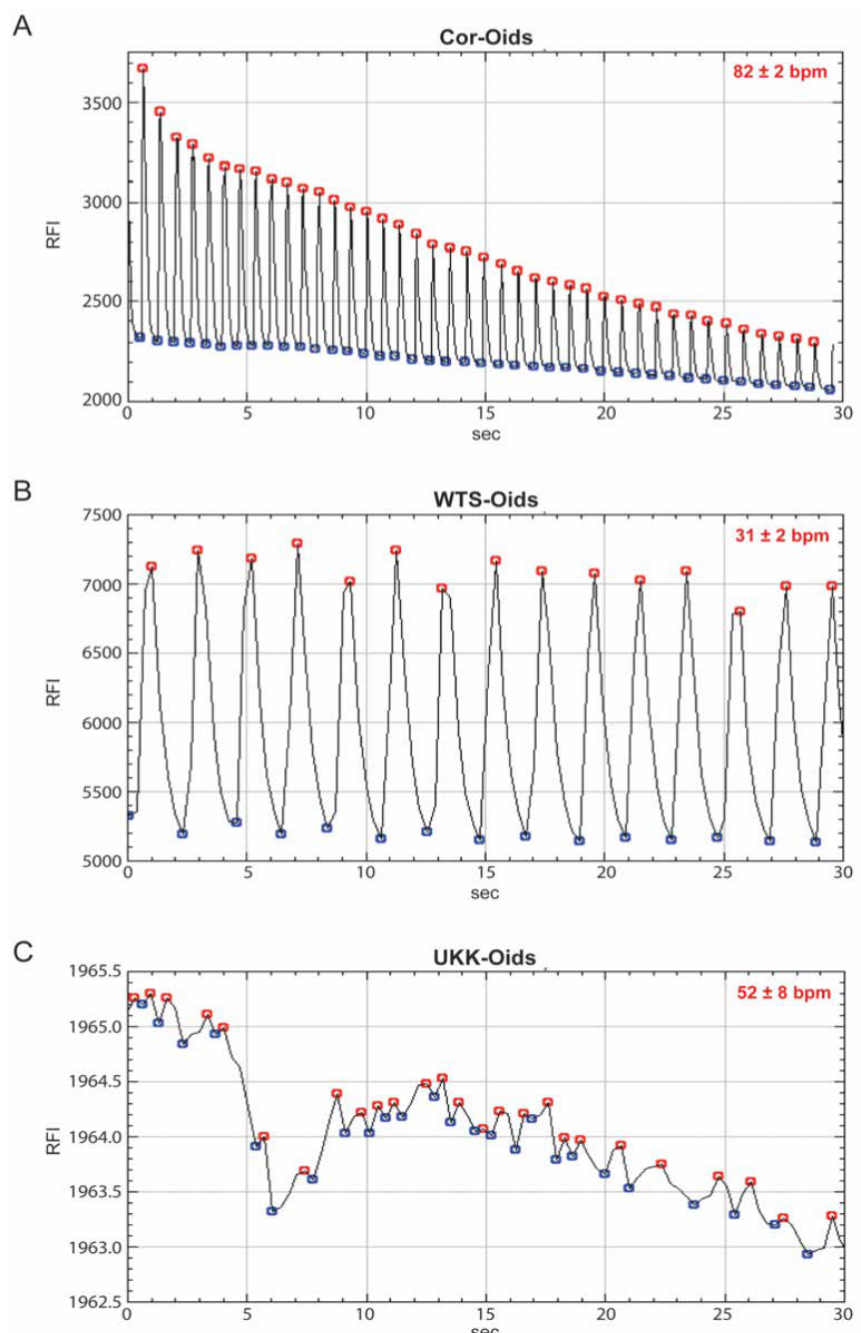
Figure 5. Patient-specific (patho-)physiological features mirrored by cardiac organoids. ( A – C ) Analysis of the beating patterns and rates of Cor-Oids, WTS-Oids and UKK-Oids on day 21 (A) Cor-Oids showed a regular beating pattern with a beating rate of 82 ± 2 bpm ( B ) WTS-Oids showed a similar regular beating pattern, but a slower beating rate than Cor-Oids ( C ) UKK-Oids presented an arrhythmic beating pattern and a significant variability in their beating rate. RFI = Relative Fluorescence Intensity.